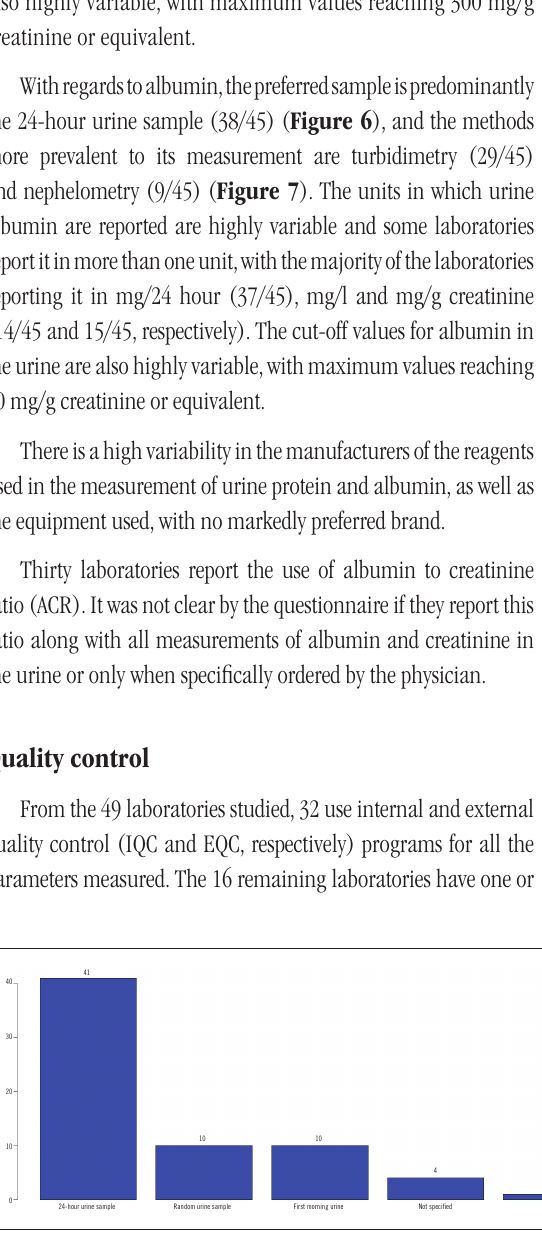
Figure 4 − Recommended sample to measure whole protein in